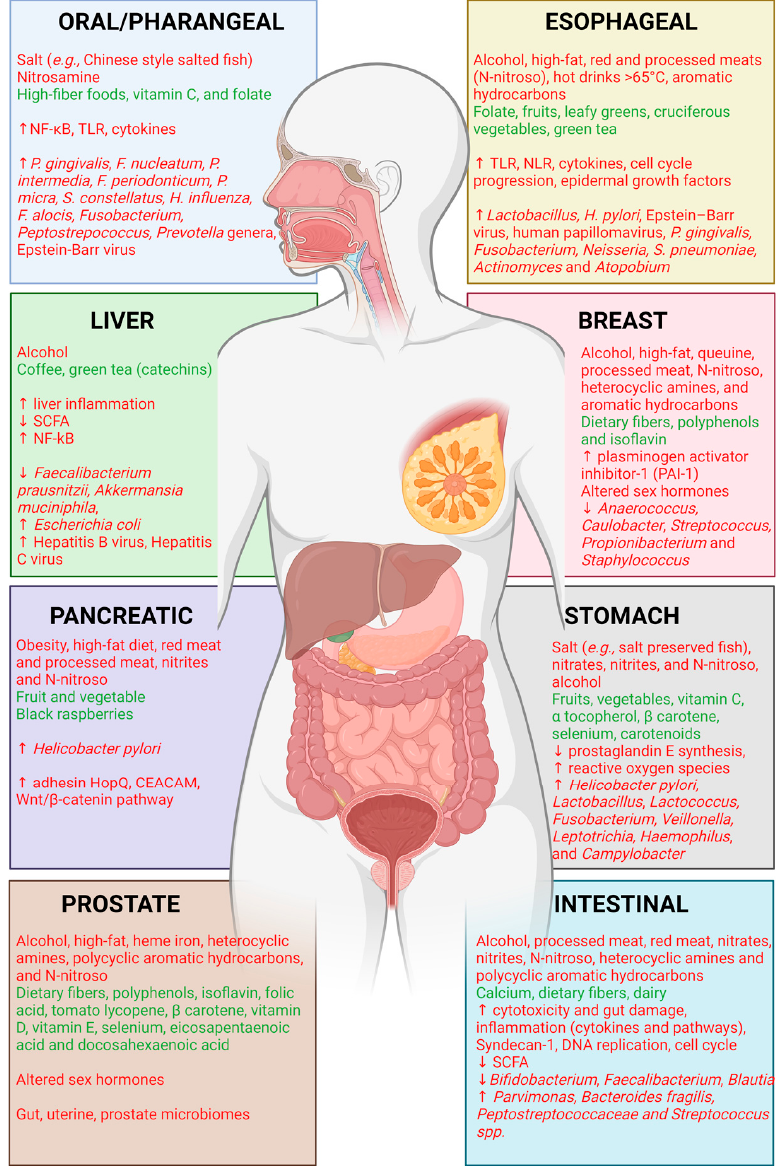
Figure 1. Brief overview of dietary factors, host pathways, and various microbiomes that have been associated with different organ system cancers described and referenced in this manuscript. Red text has been correlated with negative impacts on cancer; green text has been correlated with positive impacts on